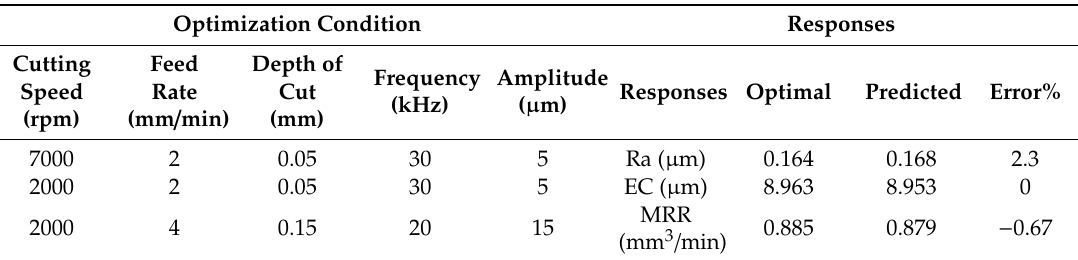
Table 9. Results of single response optimization